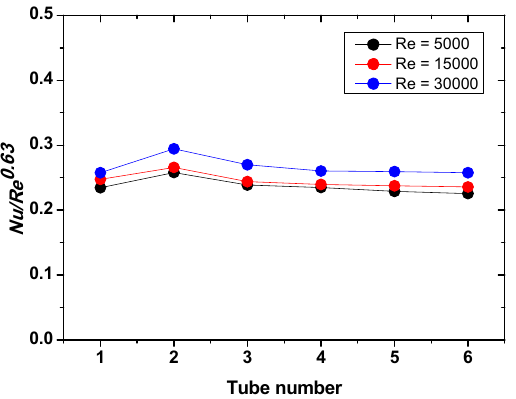
Figure 6. Area averaged Nu/Re 0.63 of each tube bundle at various Reynolds numbers.